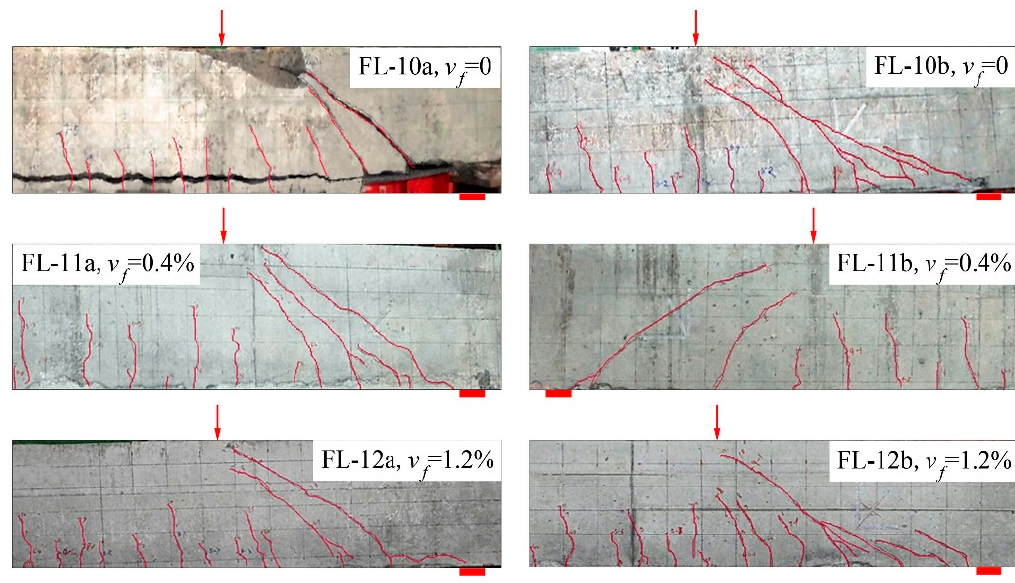
Figure 2. Crack distribution of test beams with different v f .